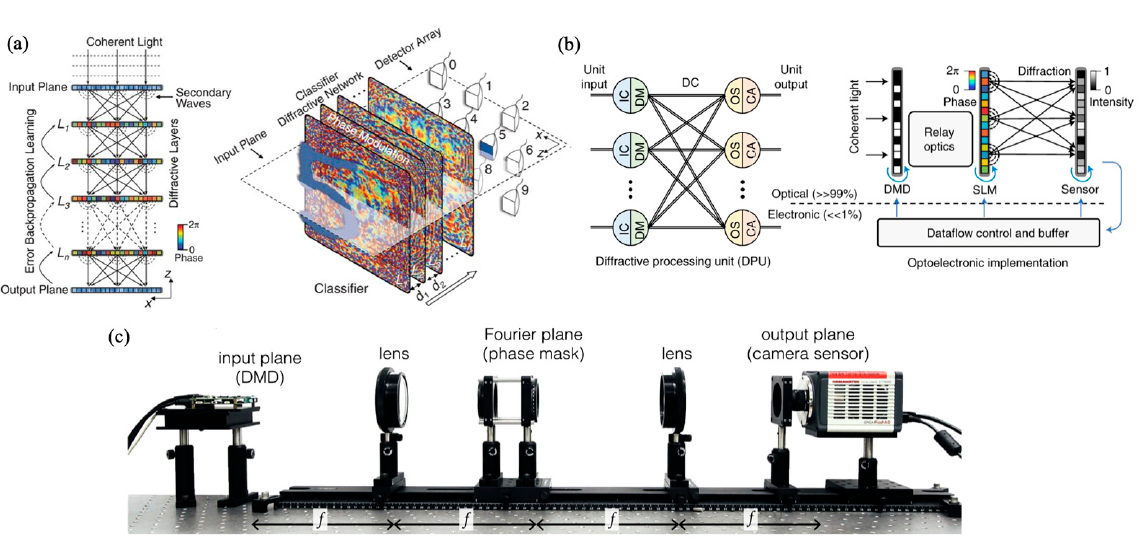
Figure 2. Implementing D 2 NNs. ( a ) Several transmission or reflection layers are 3D printed, and each point on the layer is an artificial neuron with a given weight connected to other neurons in the next layer via optical diffraction [52]. ( b ) Diffractive process units (DPUs) are designed as a large-scale perceptron class optoelectronic computing building block that can be programmed to build different deep neural networks implemented with programmable optoelectronic devices, such as digital micromirror devices (DMDs), phased spatial light modulators (SLMs), and CMOS sensors [61]. ( c ) An optical convolutional layer with an optimizable phase mask is conceived to implement a convolutional neural network using the intrinsic convolution performed using a linear spatial non-turning image system [60].